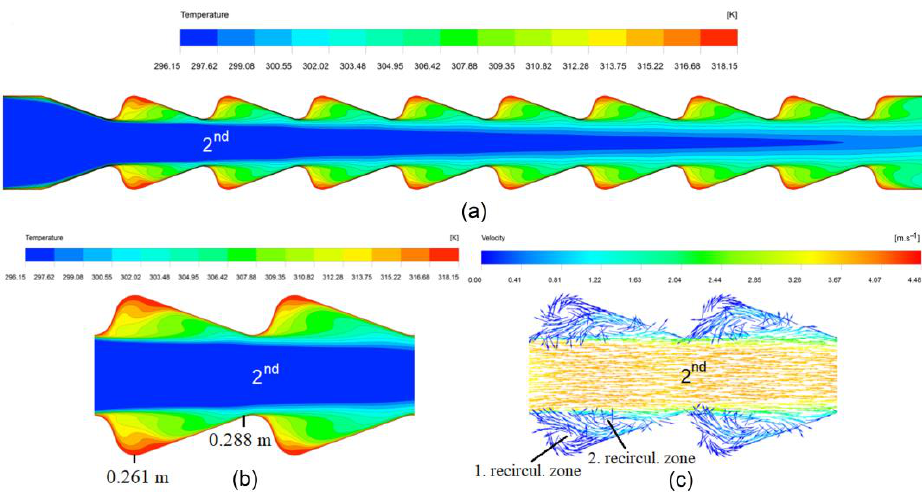
Figure 6. The temperature fields and velocity vectors of the WCA configuration ( Q = 50 m 3 /h), ( a ) temperature fields along the channel, ( b ) detail of the 2nd protrusion — temperature fields, ( c ) detail of the 2nd protrusion — velocity vectors.